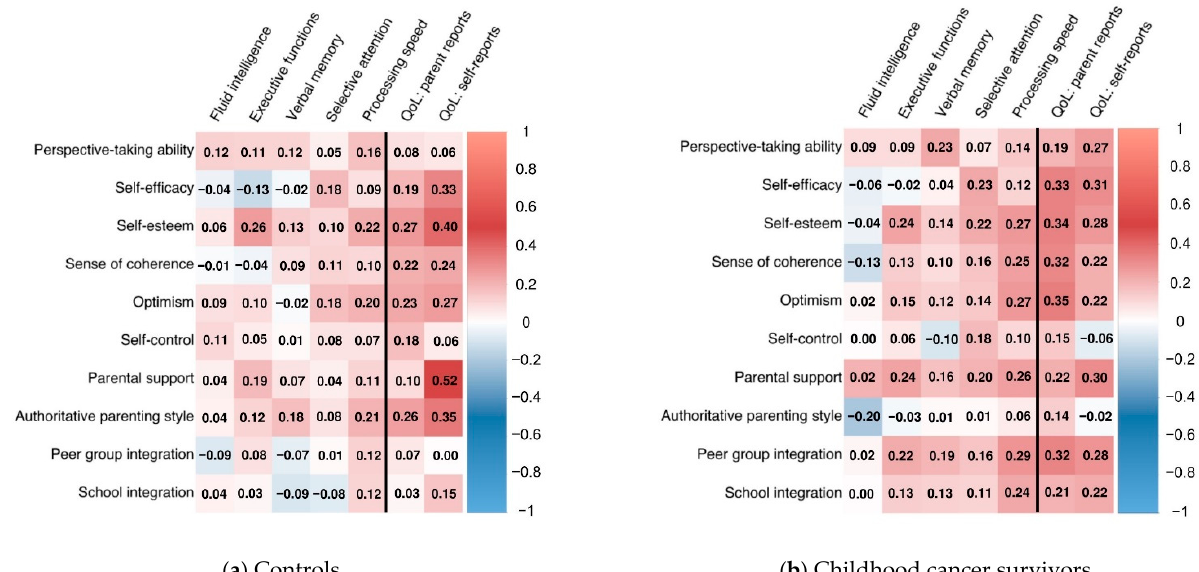
Figure 1. Correlational matrices between subscales of personal and social resources and cognition as well as quality of life in ( a ) controls and ( b ) childhood cancer survivors. Note. Two-sided Pearson correlation; color intensity indicates the strength of the correlation coefficient, red colors imply positive correlations, blue colors imply negative correlations; QoL = quality of life. No p -values withstand Bonferroni correction.